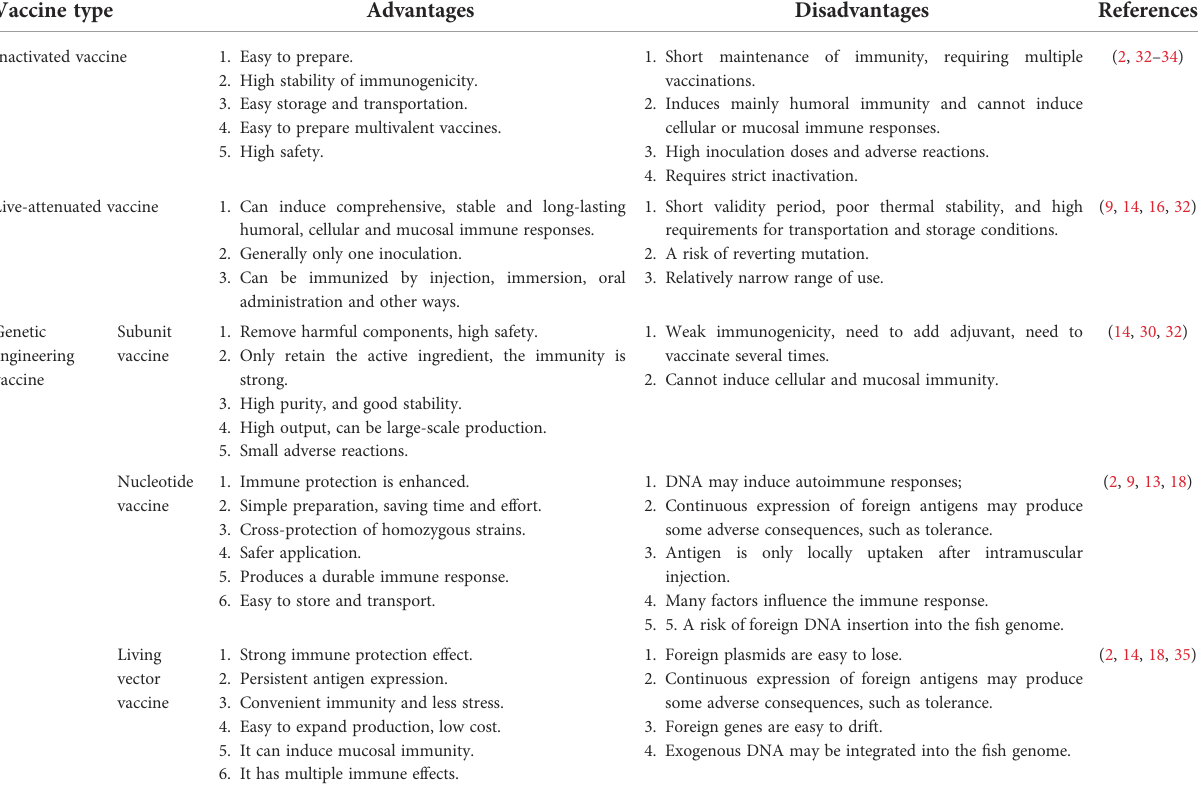
TABLE 2 Types and characteristics of aquatic